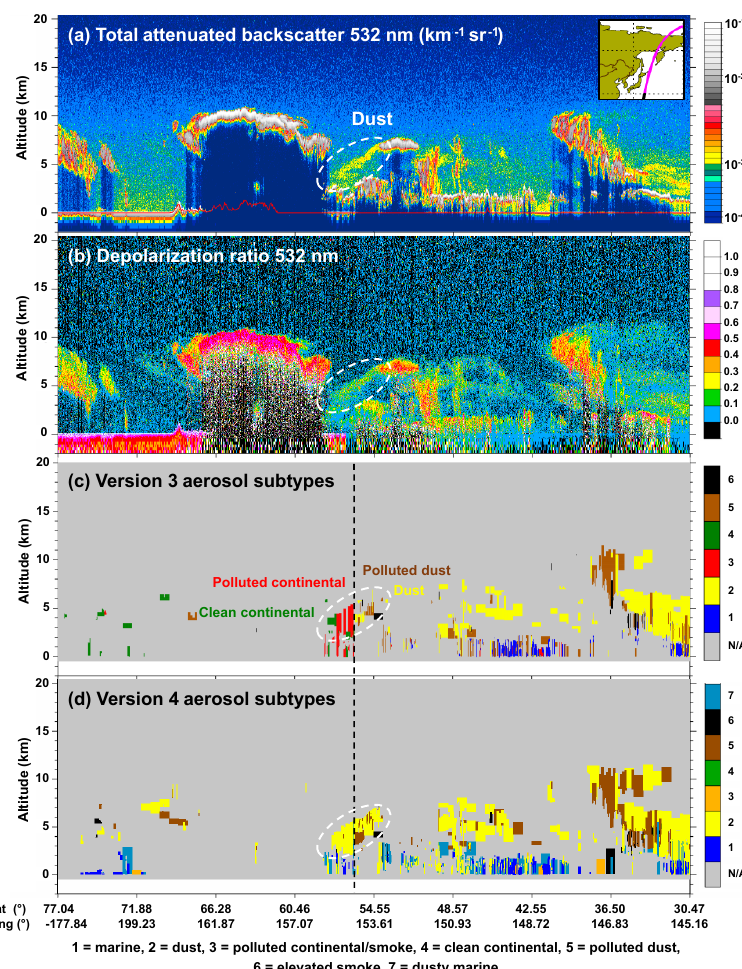
6 = elevated smoke, 7 = dusty marine